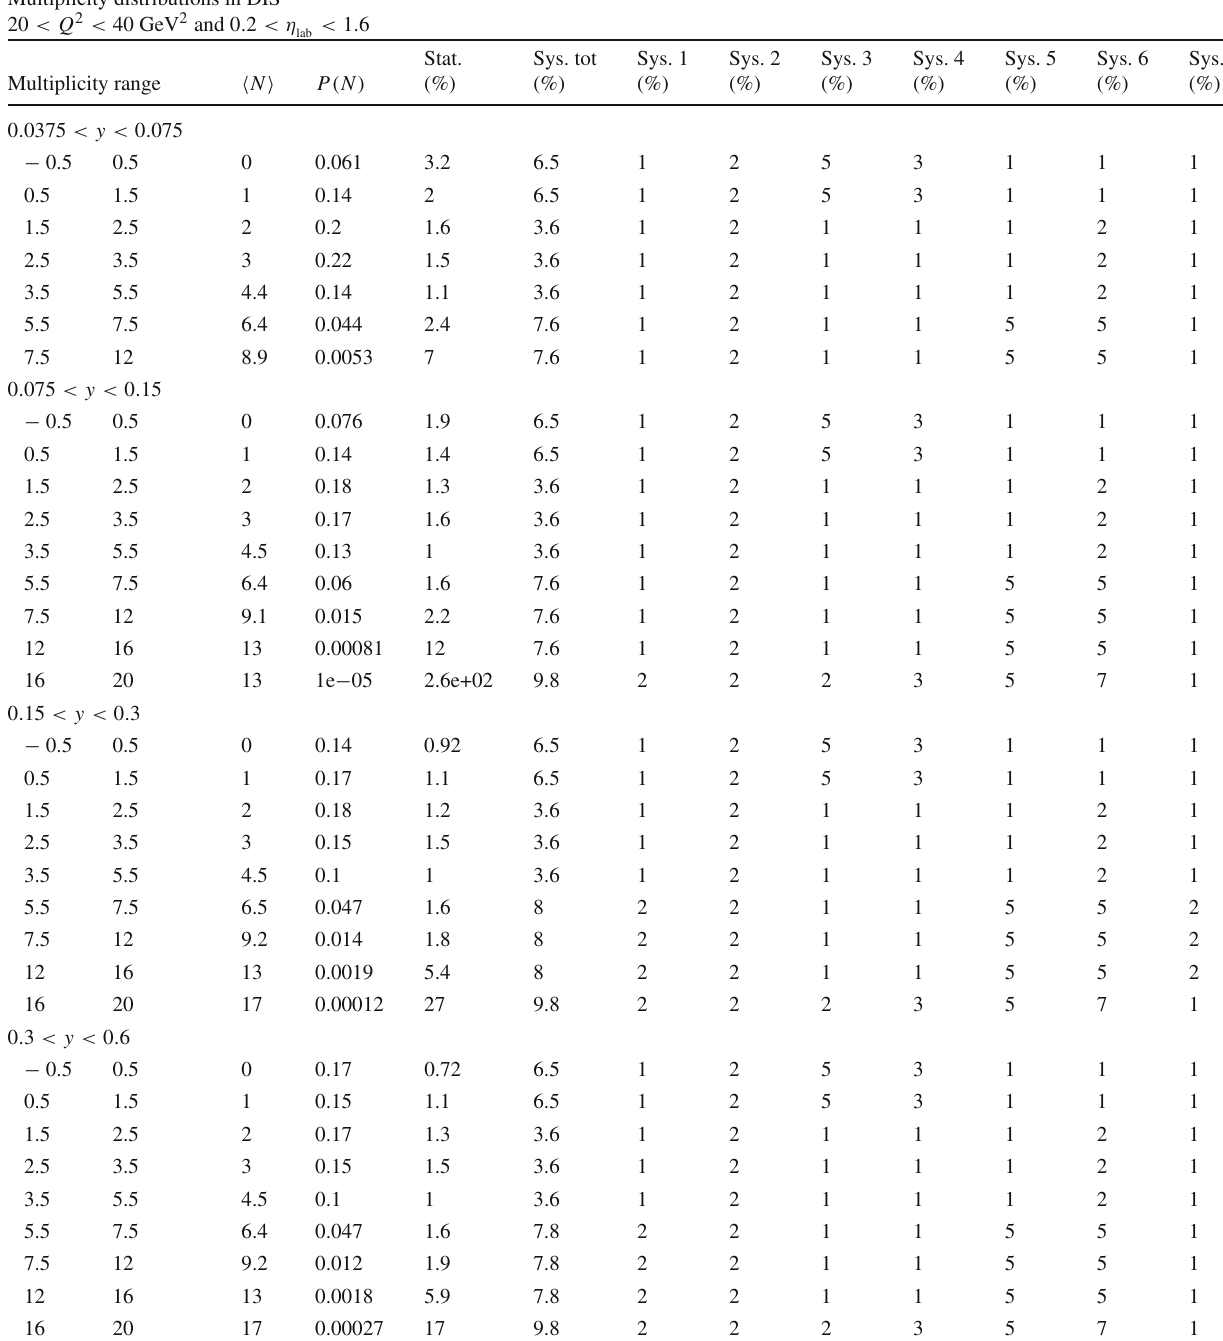
Table 21 Charged particle multiplicity distributions P ( N ) measured √ s = 319GeV with in the ranges of photon virtual- in ep DIS at ity 20 < Q 2 < 40 GeV 2 and charged particle pseudorapidity range Multiplicity distributions in DIS < 1 . 20 < Q 2 < 40 GeV 2 and 0 . 2 < η lab